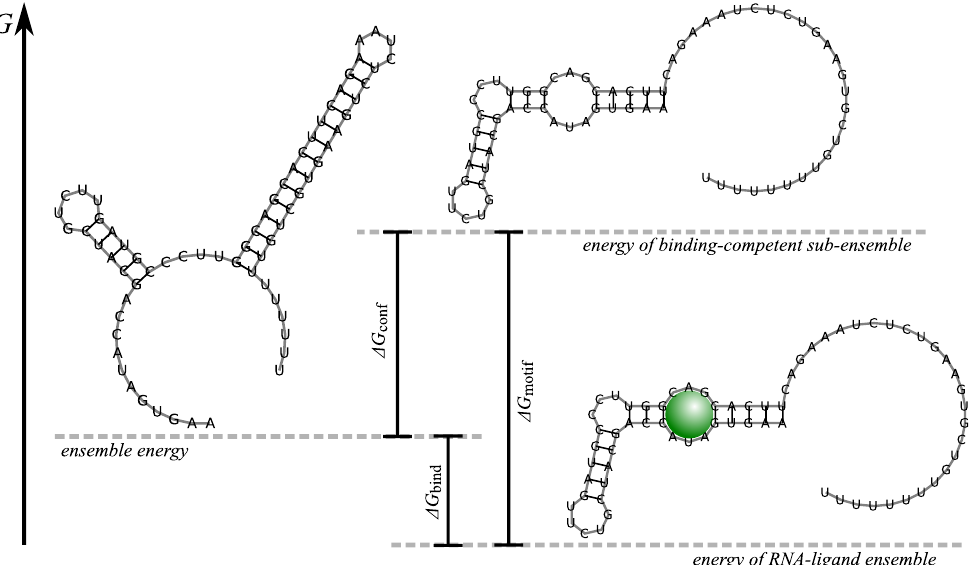
Figure 2. Ligand binding and structural stabilization of the aptamer—schematic illustration based on the theophylline aptamer. The sub-ensemble of binding competent structures ( middle ) is raised over the unbound structure ensemble ( left ) by the energy ∆ G conf required for the formation of the binding pocket. Due to the RNA–ligand binding energy ∆ G motif the RNA–ligand complex ( right ) is stabilized over the unbound structures by the energy ∆ G bind . Note that the ensembles are simply visualized by representative structures—while consisting of many secondary